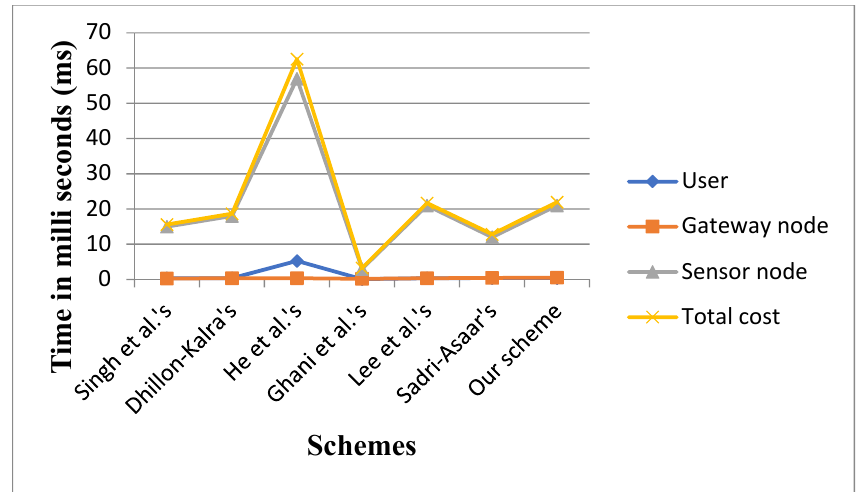
Figure 10. Cryptographic function and their description for computation cost.